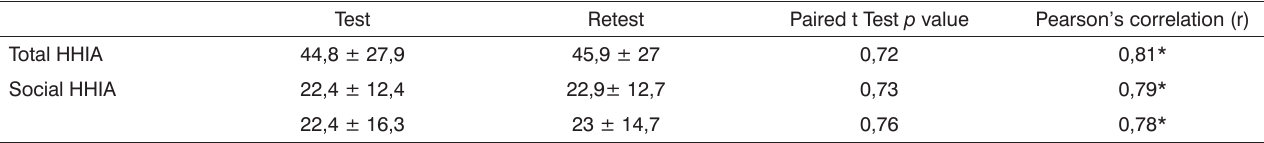
Table 3. Mean and standard deviation values from the scores obtained; how significant is the comparison between the means and correlation of the results from the test and retest for Group B participants (n=32).